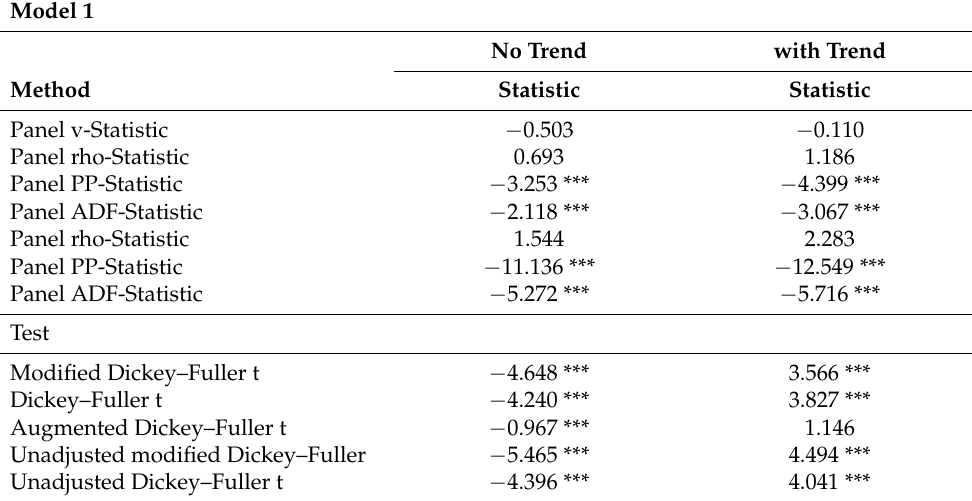
Table 8. Panel cointegration tests. Pedroni panel cointegration test and Kao Residual Cointegration for model 1.